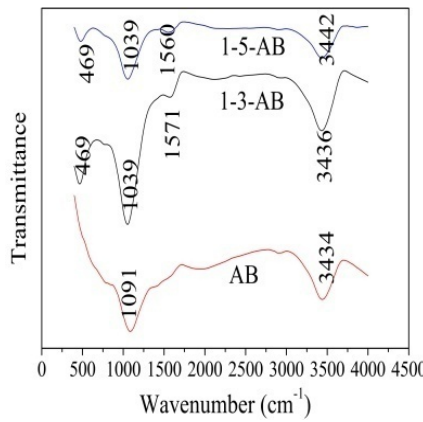
Figure 4. FTIR spectra of the three biochar samples before adsorption of RBR.